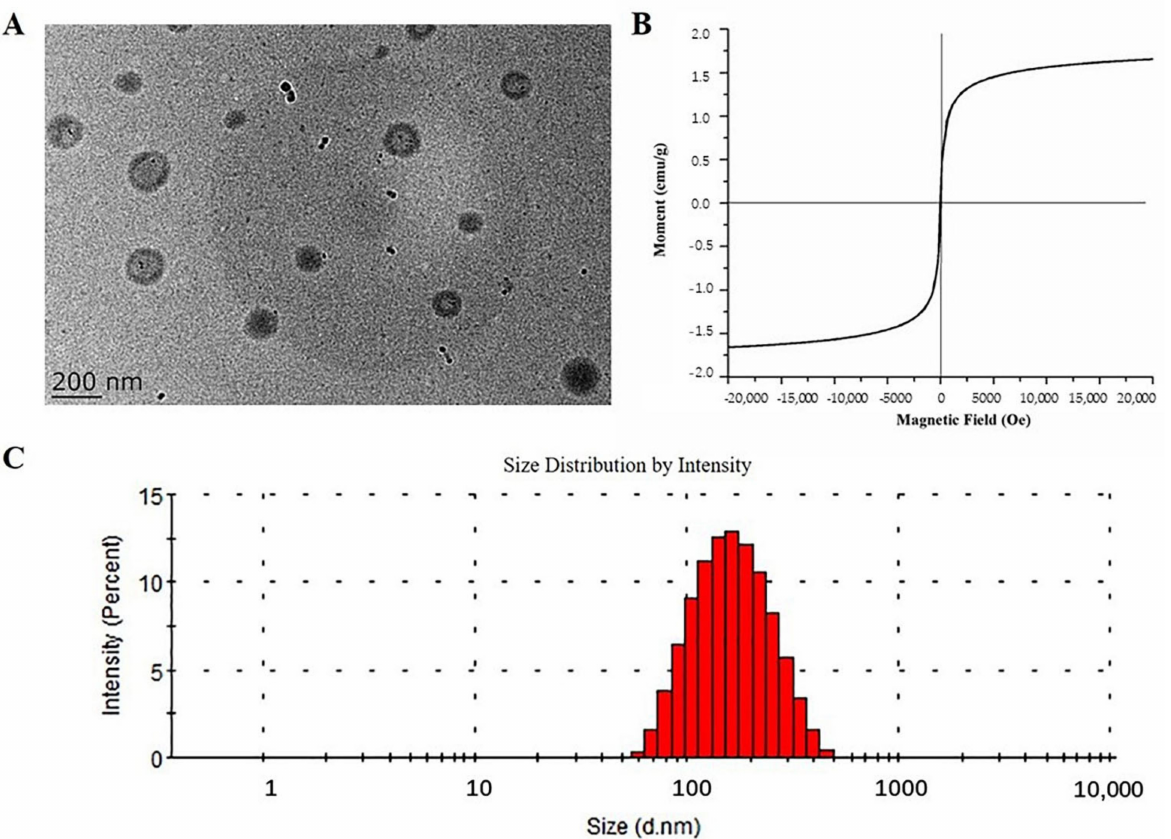
Figure 2. Characterizations of Fe 3 O 4 @PLGA-PEG-NH 2 MNPs. ( A ) TEM image; ( B ) hysteresis loop; ( C ) particle size distribution